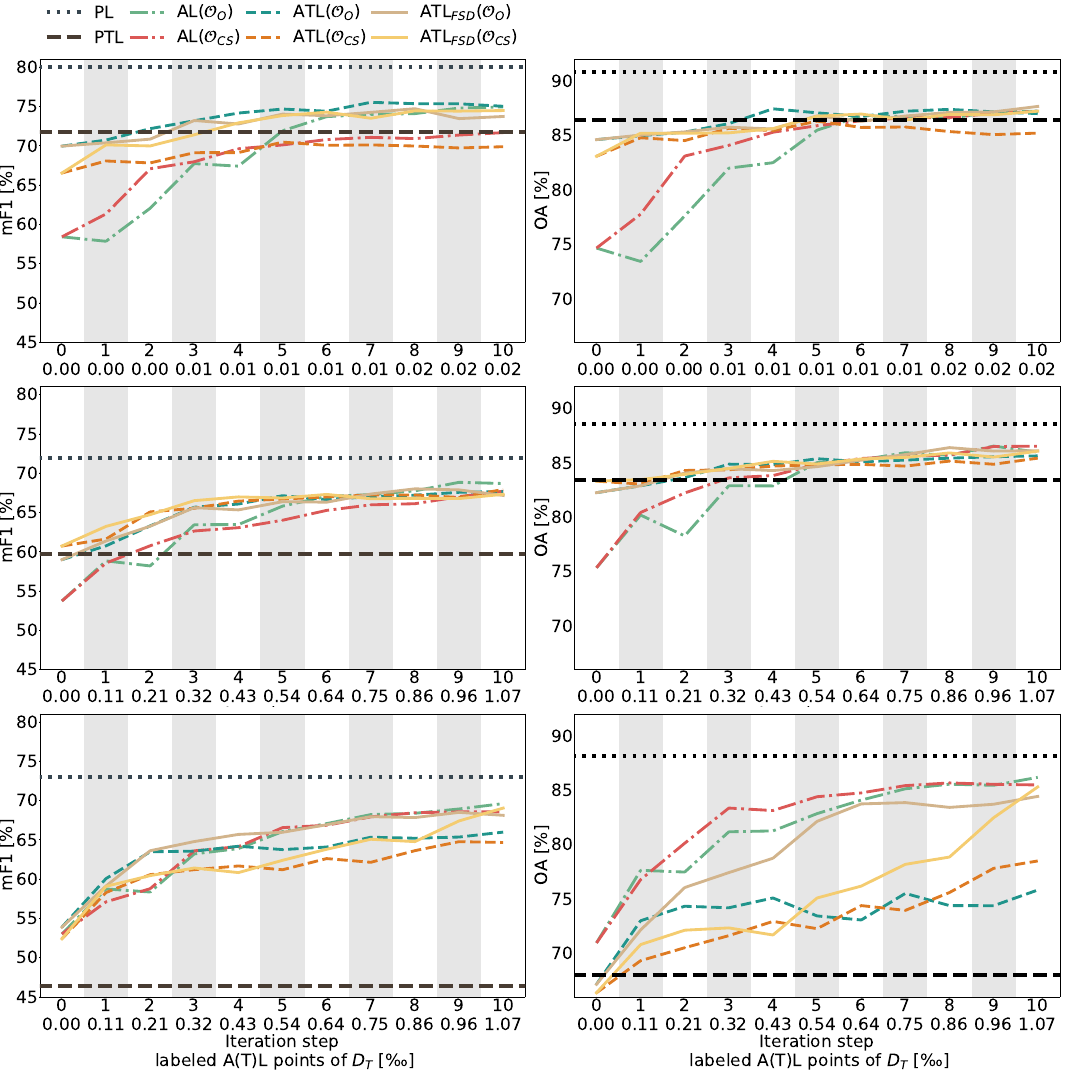
Figure 3. Results of our simulated runs for scenario I-III ( top to bottom ) evaluated in terms of mF1 and OA (number of initialization points is not included in the relative proportion of labeled points in case of pure AL